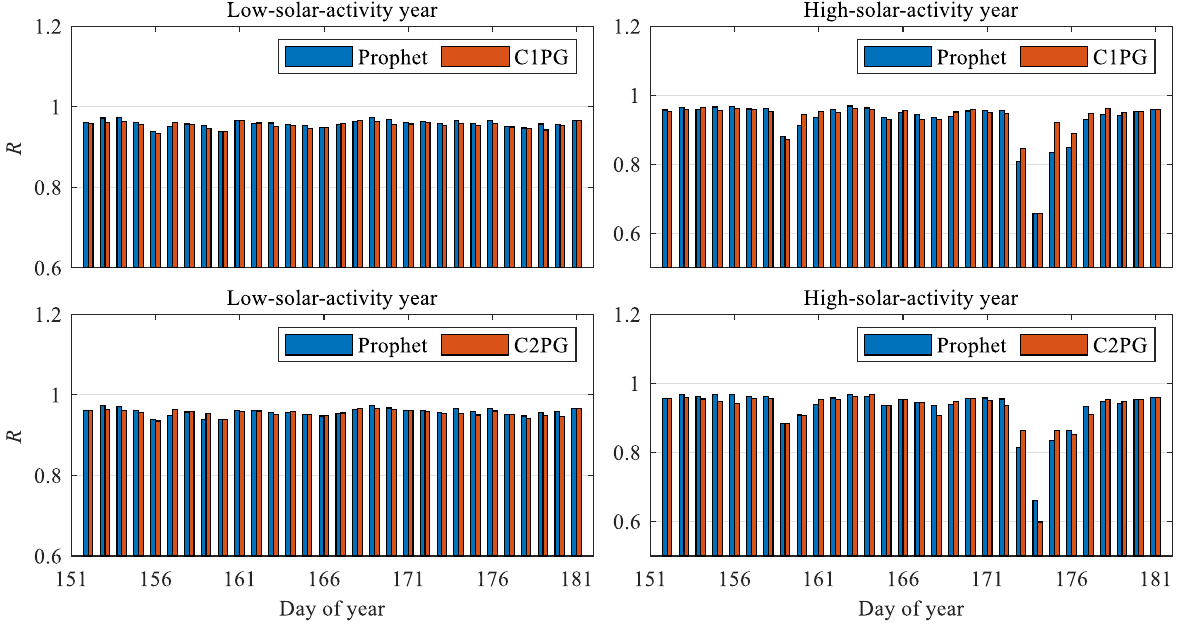
Figure 14. Daily correlation coefficient statistics of the Prophet model and the COPG value, C1PG and C2PG refer to COPG values forecast for the first and second day. Blue represents the Prophet model, and orange represents the COPG value.